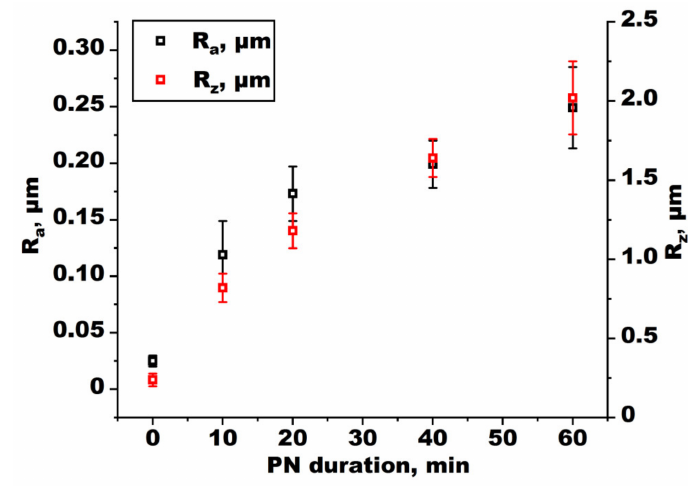
Figure 6. The dependence of R a and R z parameters on the PN duration.